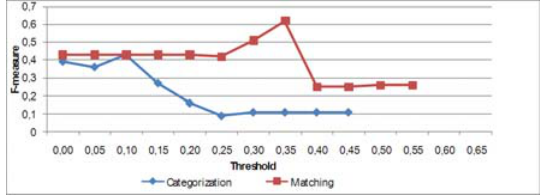
Fig. 4. The F-measure curves for the categorization and matching with the Lin